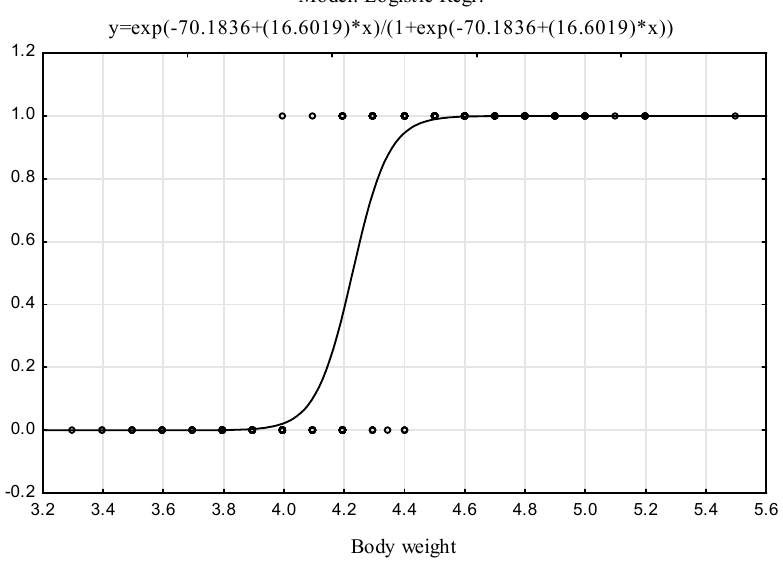
Figure 3. Fitted logit function and observed values (1 = A, 0 = J). Table 2. Parameter evaluation in the logistic regression model in relation to body weight. N = 297